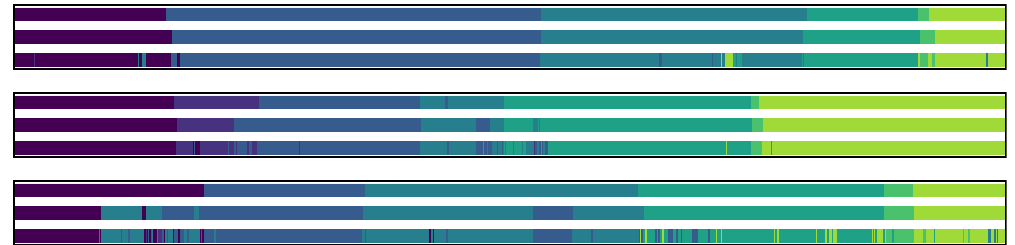
Figure 3. Comparing the true labels vs. model predictions. Three different videos from the test set are depicted. These videos represent the 90th percentile (top), median (middle) and 10th percentile (bottom) of the test set accuracy values. The top row of each video represents the sequence of true labels, the middle row represents the long-term model predictions and the bottom row represents the short-term model predictions. Each phase segment is illustrated with a different